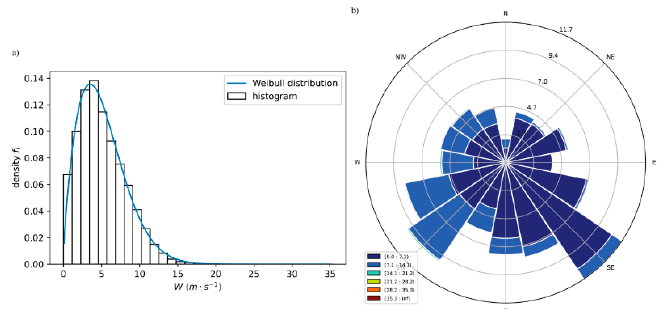
Figure 9. ( a ) Wind speed (m s − 1 ) histogram and estimated Weibull distribution probability density function and ( b ) wind rose at Nowa Pas łę ka meteorological station (2008–2017).